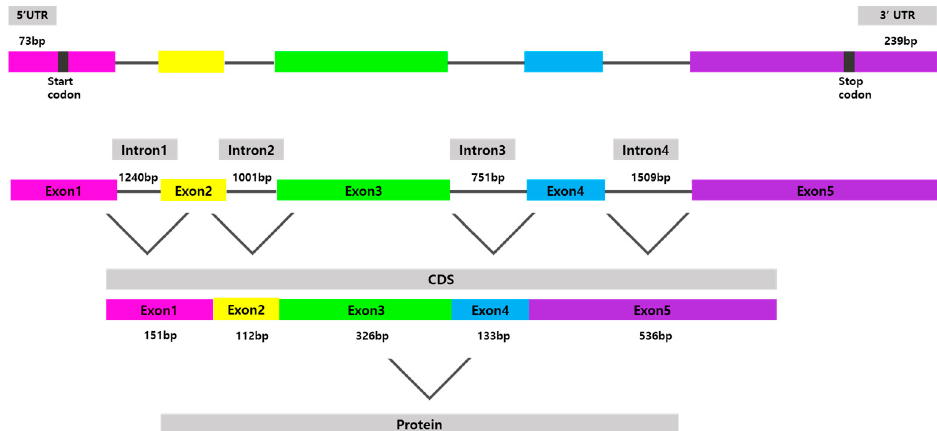
Figure 2. Physical map of cloned psdnd. The psdnd open reading frame (ORF) contains 5 exons and 4 introns. Revealed 73 bp of 5 ′ UTR and 239 bp of 3 ′ UTR. Each exons are shown in different color boxes. Introns expressed thin grey lines.